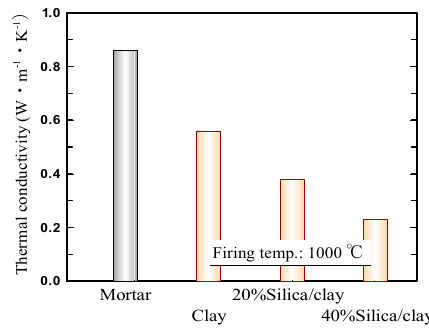
Figure 4. Thermal conductivities of the ceramics.